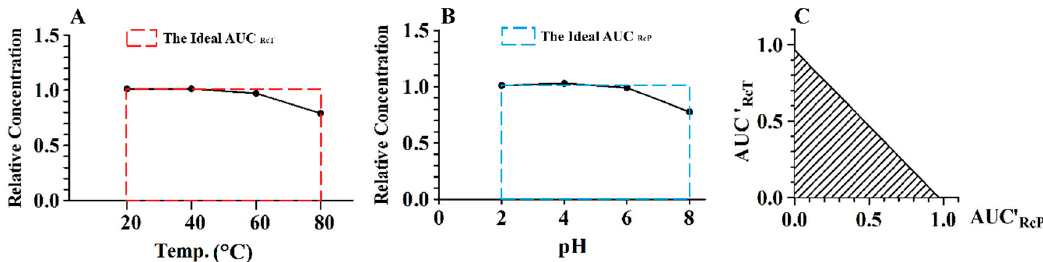
Figure 4. Relative concentration–temperature curve of CGA ( A ); relative concentration–pH curve of CGA ( B ); calculation model of sensitivity index (SeI) and stability index (StI) for CGA ( C ).